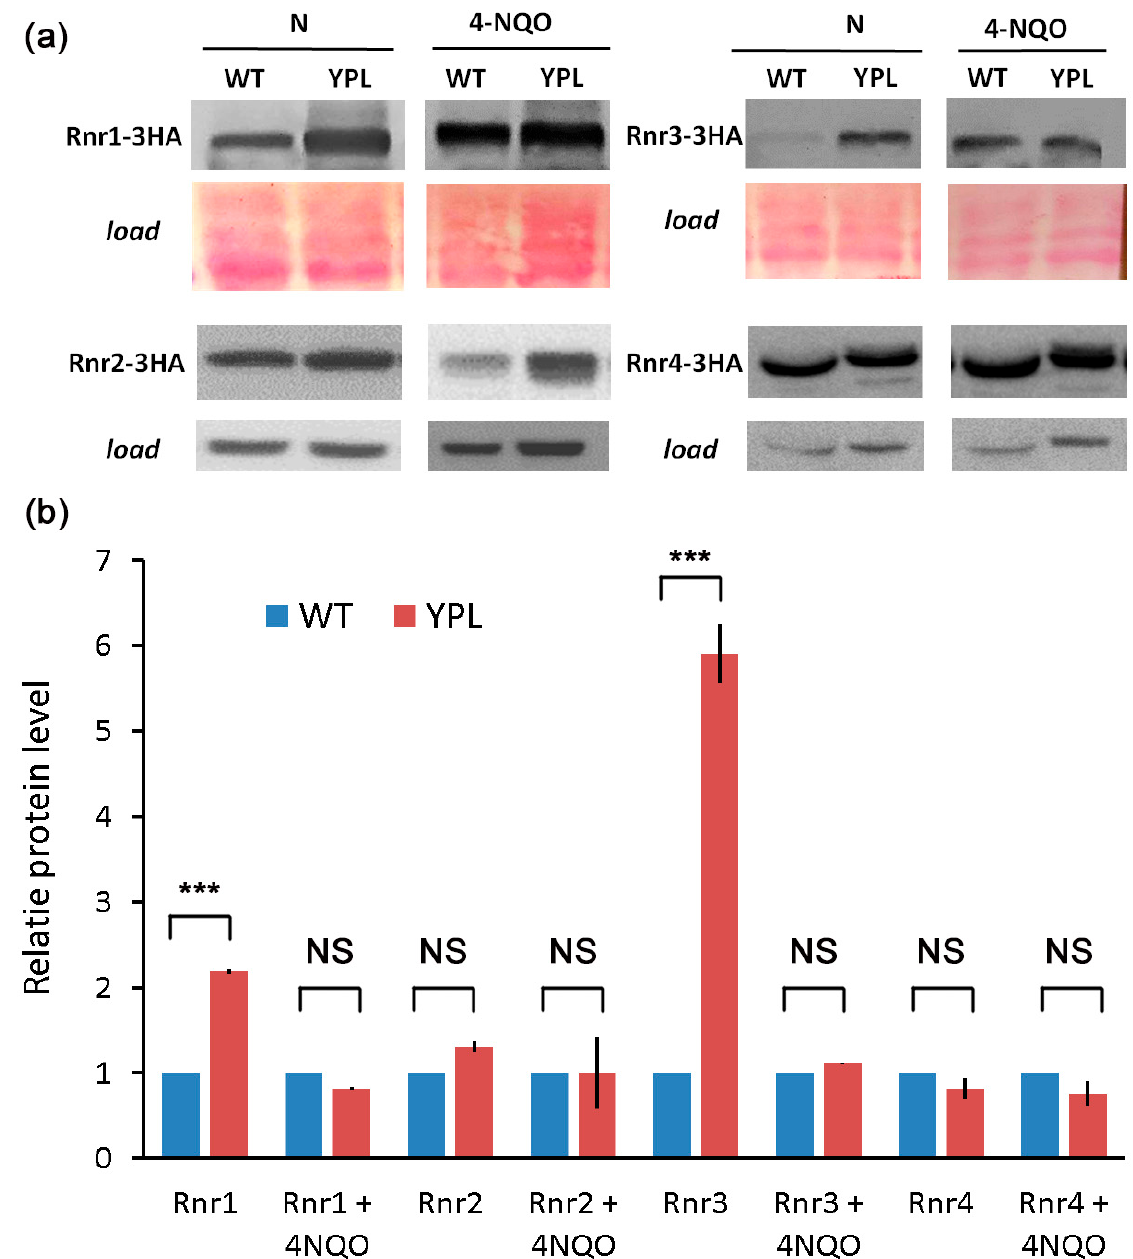
Figure 2. ( a ) Western blot analysis of Rnr-3HA proteins expressed from a low-copy vector in WT and YPL strains confirmed the accumulation of Rnr1 and Rnr3 subunits in the YPL strain compared to the WT strain. Ponceau (for Rnr1,3) or tubulin (for Rnr2,4) staining was used as a loading control. ( b ) Quantification of Western blotting results using ImageJ. The signal of the protein bands in the WT was set to 1. Data represent the mean ( n = 2) ± SDs. Statistical significance: NS, not significant; *** p < 0.001, according to Student’s t -test.